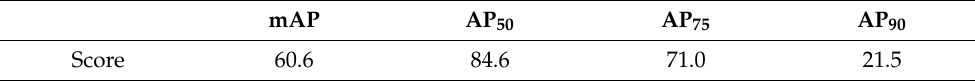
Table 3. AP score for detection evaluation of Mask R-CNN over SEM images of TiO 2 particles.